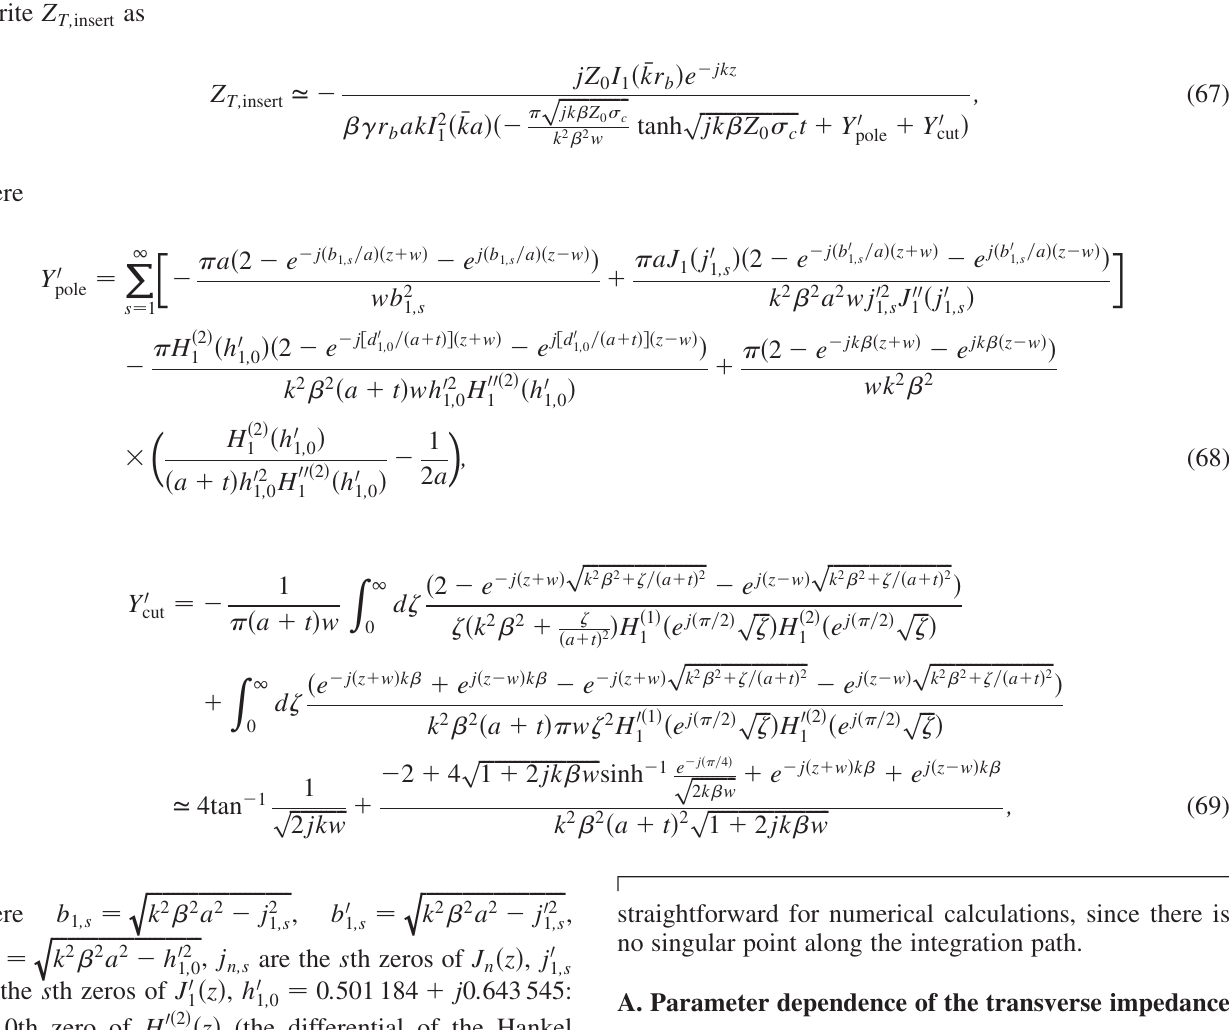
ffiffiffiffiffiffiffiffiffiffiffiffiffiffiffiffiffiffiffiffiffiffiffiffi p (cid:1) 2 þ 4 1 þ 2 jk(cid:4)w 1 ffiffiffiffiffiffiffiffiffiffiffi